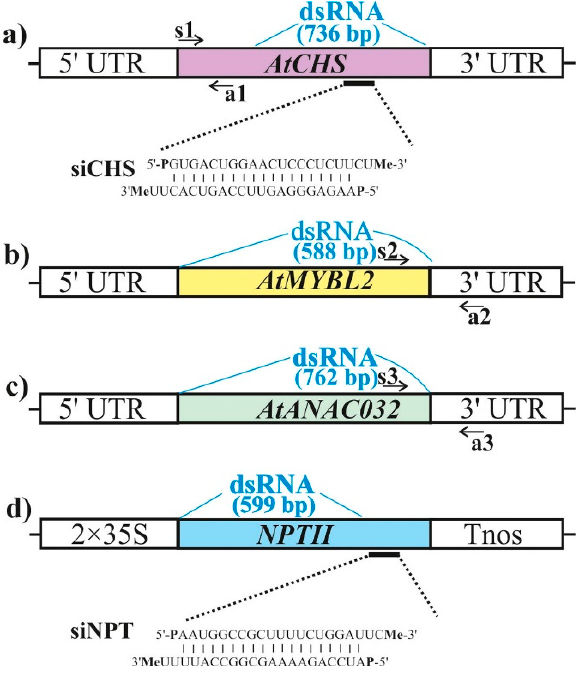
Figure 2. Schematic representation of the dsRNA position and siRNAs structures used in this study and the qRT-PCR primers designed to verify the effects of external RNA treatments on the levels of endogenous AtCHS , AtMYBL2 , and AtANAC032 mRNAs. ( a ) Representation of AtCHS cDNA coding region with positions of the AtCHS- specific dsRNA and siRNA; ( b ) representation of AtMYBL2 cDNA coding region with position of the AtMYBL2 -specific dsRNA; ( c ) representation of AtANAC032 cDNA coding region and position of AtANAC032 -specific dsRNA; ( d ) representation of NPTII coding region and positions of the NPTII -specific dsRNA and siRNA. Black arrows indicate positions of the primers (s1, a1, s2, a2, s3, a3) used for amplification of the endogenous AtCHS , AtMYBL2 , and AtANAC032 transcripts. UTR—untranslated region. 2 × 35S—the double 35S promoter of the cauliflower mosaic virus (CaMV). Tnos—nopaline synthase terminator.